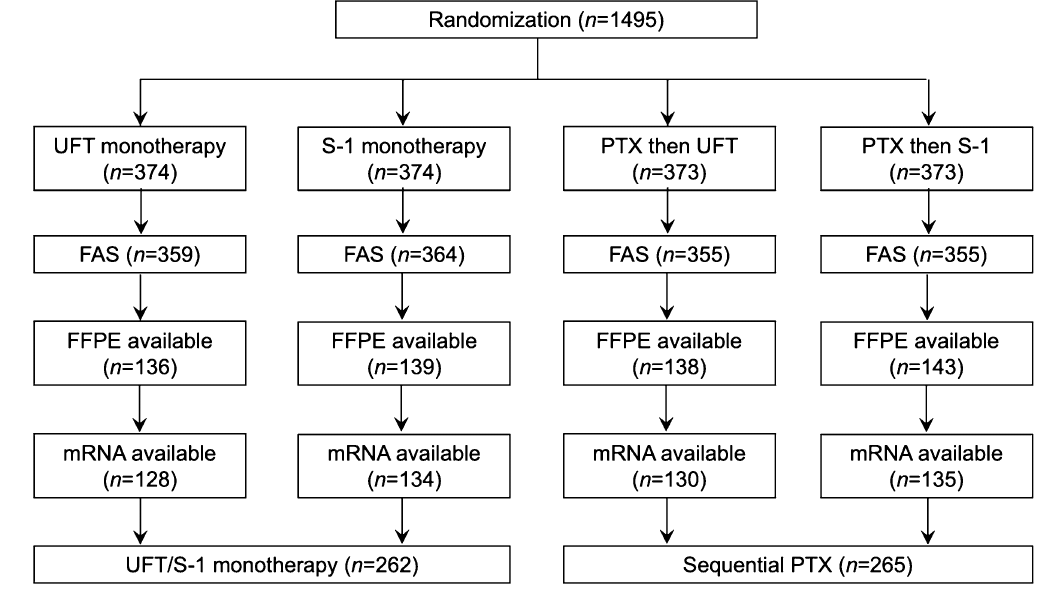
Figure 1. Flowchart of SAMIT patients available for primary analysis and subsequent biomarker analysis. Formalin-fixed, paraffin-embedded (FFPE) samples were available from 556 SAMIT patients. Twenty-nine patients had to be excluded owing to insufficient